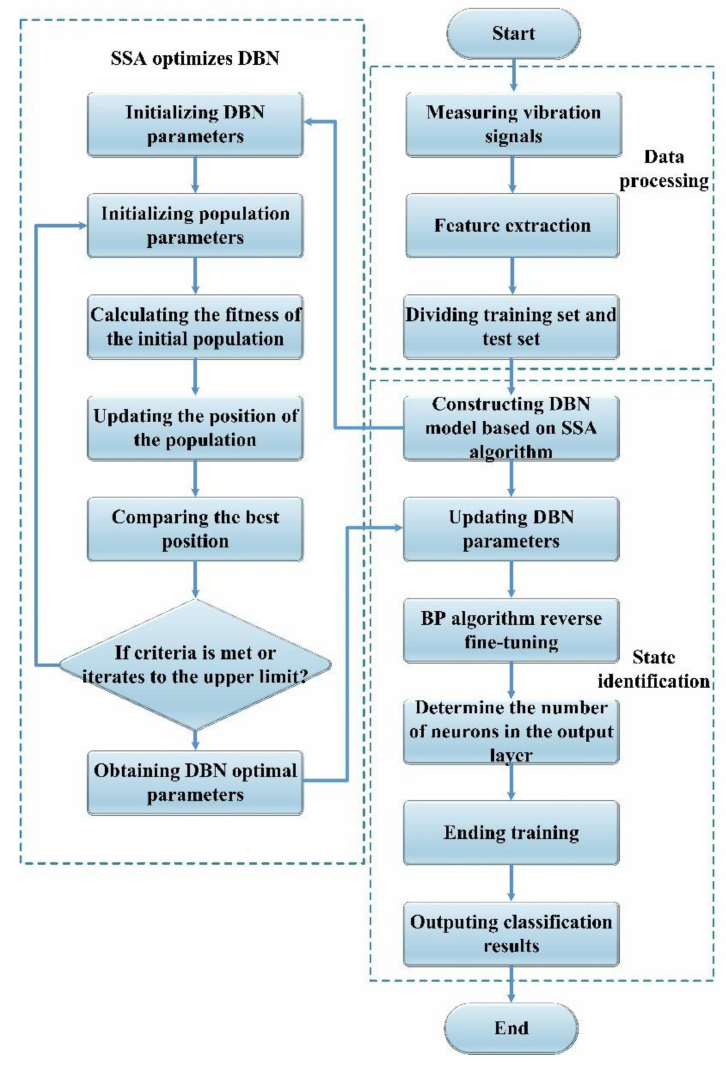
Figure 8. Flow chart of DBN optimization algorithm